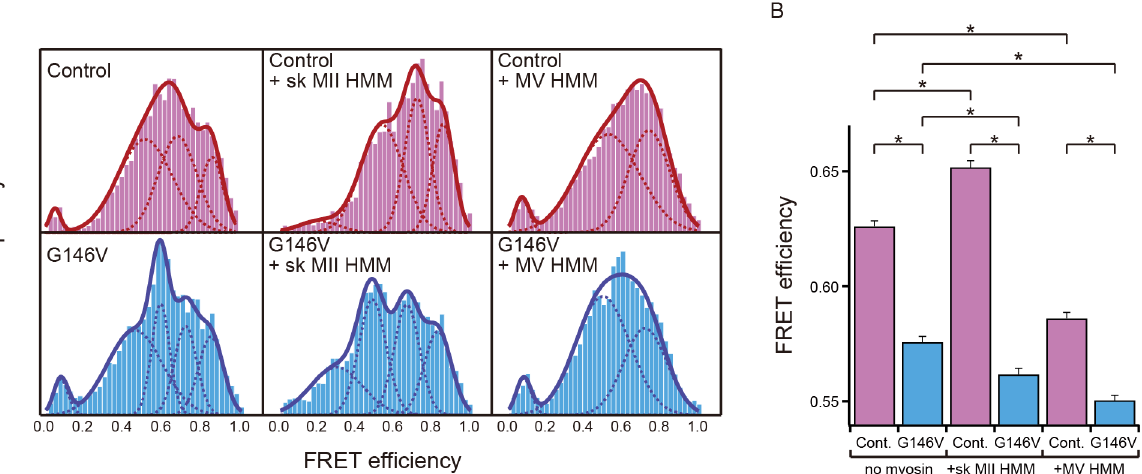
Fig 3. FRET distributions. (A) Upper and lower panels show histograms of the FRET efficiencies of control FRET actin (red) and G146V FRET actin (blue), respectively. Assays were performed in the absence (left) and in the presence of sk MII HMM (middle) or MV HMM (right). The dashed lines and thick lines show each component of the fitted Gaussian distributions and their sum, respectively. The number of data points subjected to FRET analysis is shown in S1 Table. (B) Changes in mean values calculated from overall FRET efficiencies induced by interaction with HMM. Statistical significance was assessed through the Mann — Whitney U-test. Asterisks indicate statistical significance (p < 0.00001). Error bars show SEM. All assays were performed in the presence of 1 mM ATP and the ATP regeneration system.